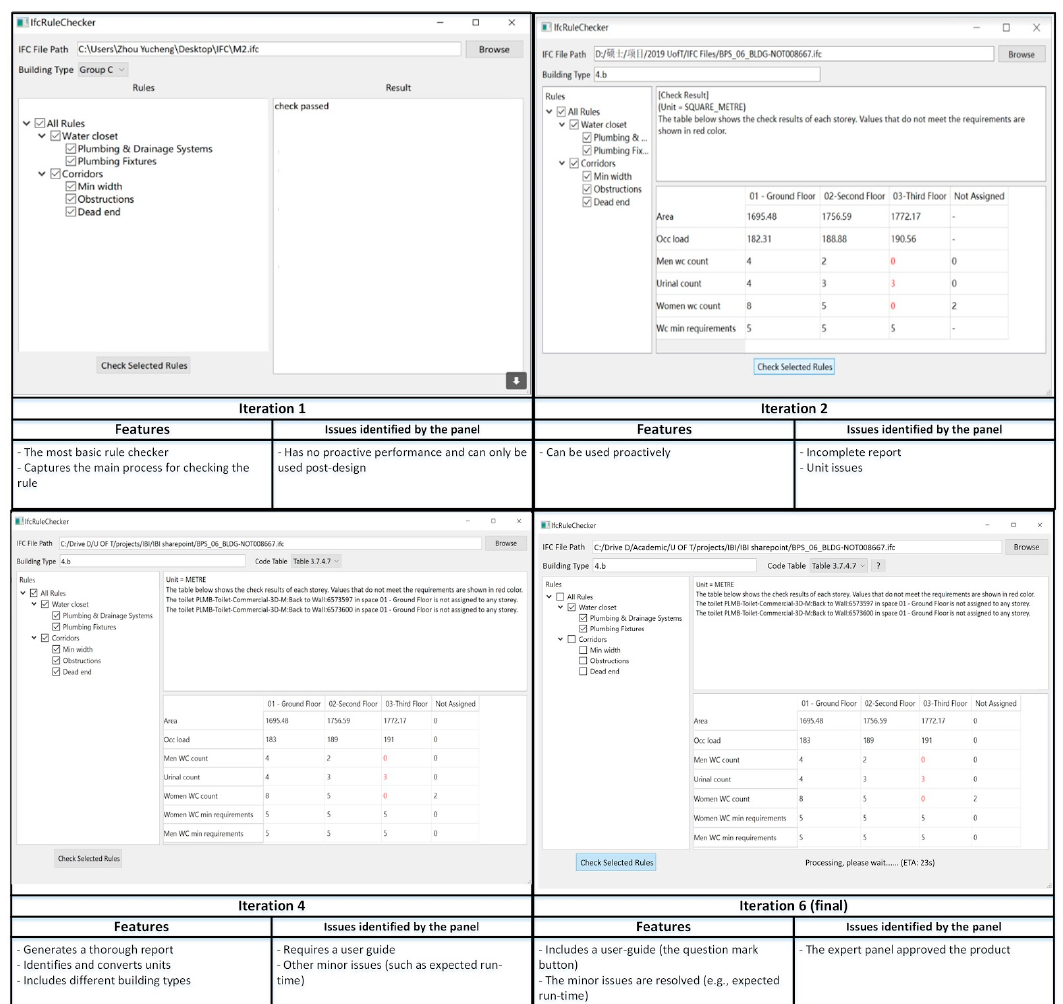
Figure 6. ARC systems, their features, and issues after iterations 1,2,4, and 6.